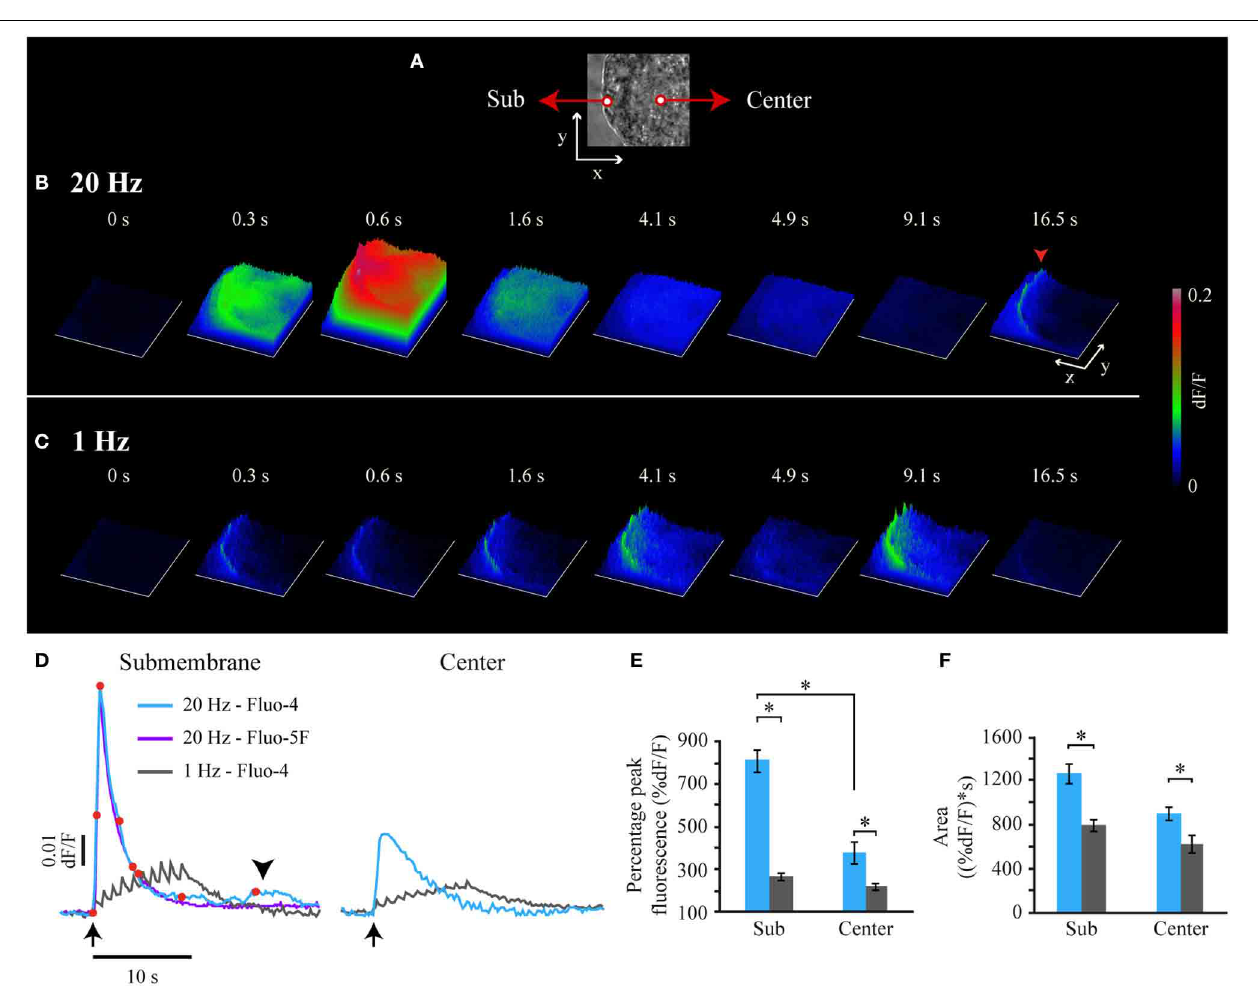
FIGURE 2 | Frequency-dependence of the fast Ca 2 + transient. (A) Bright field image of the soma from which the fluorescence surface plots in (B,C) were made. The x and y axis = 20 µ m. (B) Sequence of Fluo-4 fluorescence surface plots obtained after 20-Hz stimulation at t = 0s. The time is the same for (B,C) and corresponds to the time indicated by the red dots over the fast Ca 2 + transient upon 20Hz stimulation shown in (D). The z axis is the fluorescence intensity in arbitrary units, according to the calibration on the right. At 0.6s the fast Ca 2 + transient had reached the soma center. A submembrane small Ca 2 + transient appeared 16.5s after the stimulation train (red arrowhead). See also the supplemental Movie 1. (C) Sequence of Fluo-4 fluorescence surface plots upon 1-Hz stimulation. This Ca 2 + increases failed to invade the soma center. See also the supplemental Movie 2. (D) Superimposition of Fluo-4 and Fluo-5F fluorescence transients upon 20-Hz stimulation (blue